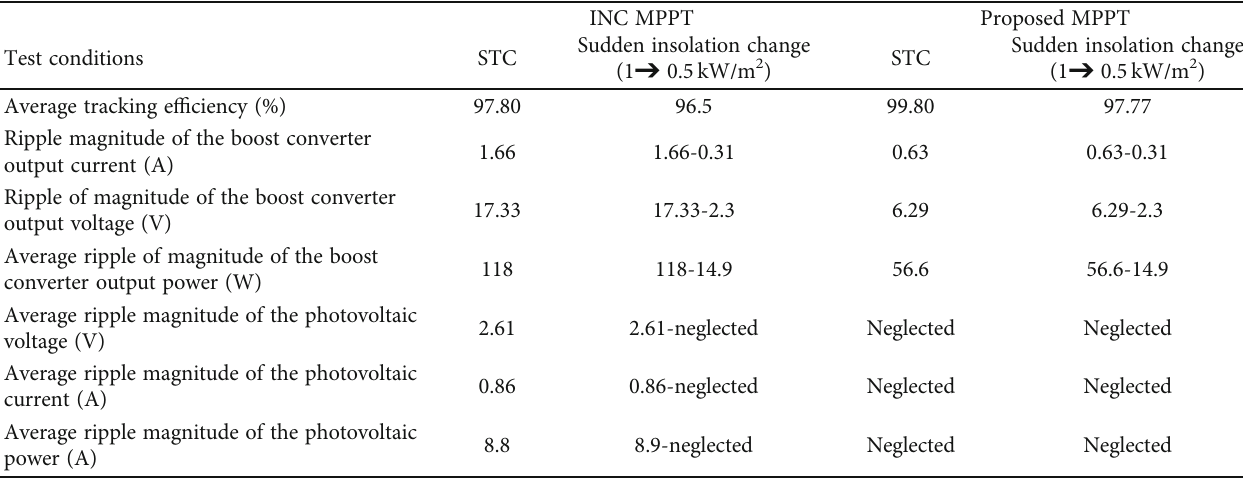
Table 4: Summary of the performance comparison of the proposed MPPT and INC MPPT schemes during real-time veri fi cation using the RT-LAB simulator.